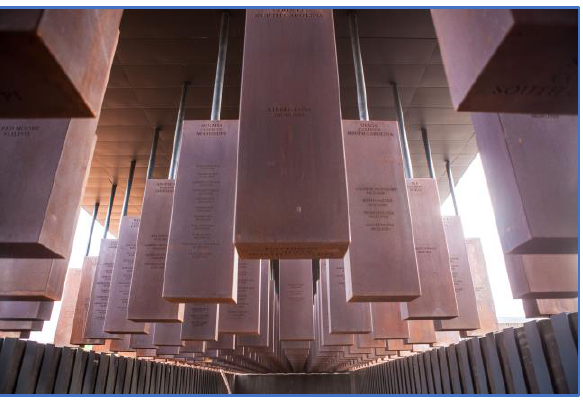
Figure 7. National Memorial for Peace and Justice (Montgomery, 2018).